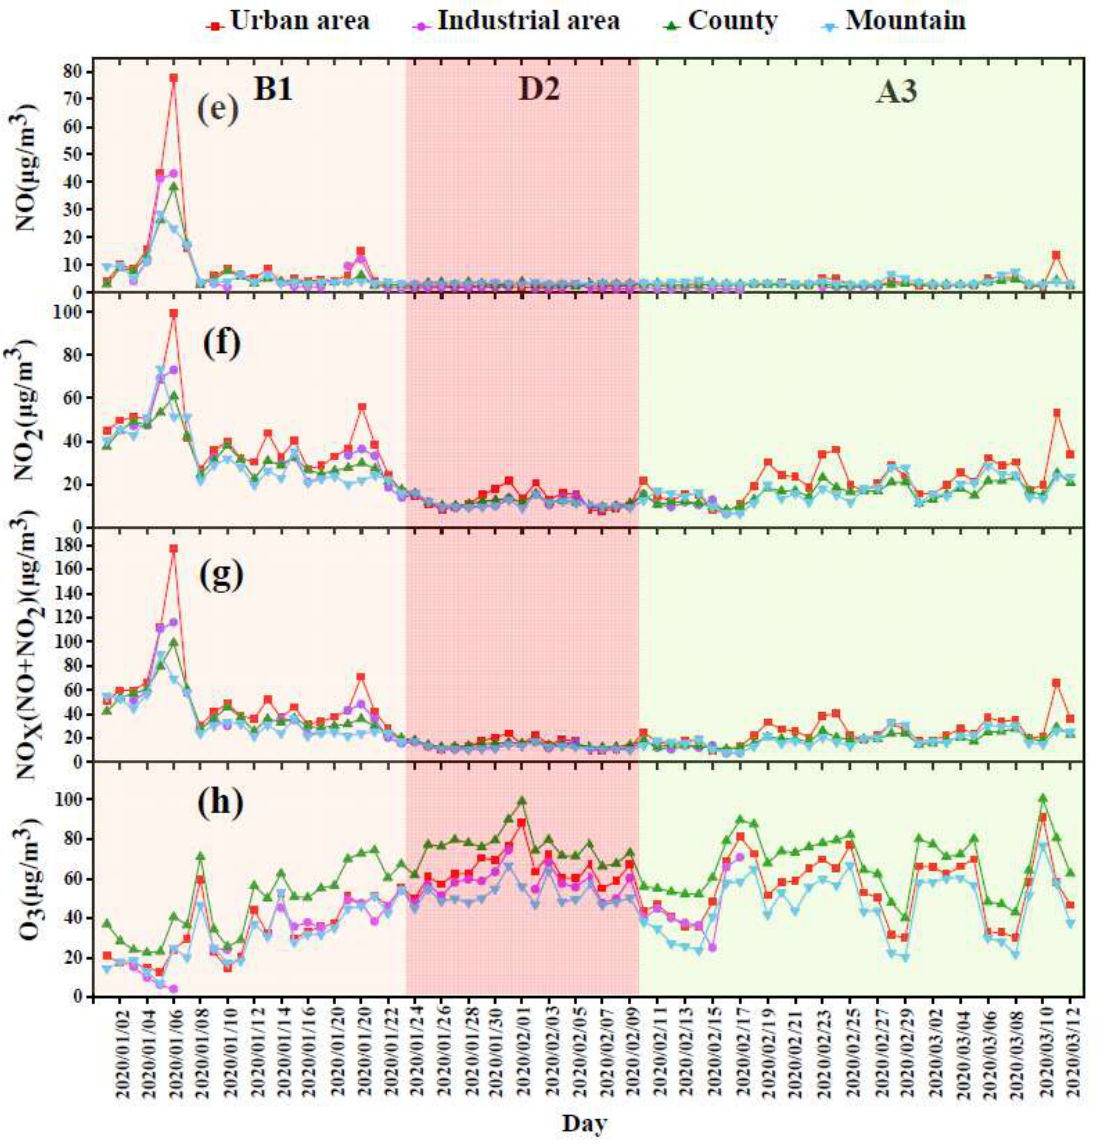
Figure 7. Daily mean concentrations of air pollutants of four regions in Nanchang from 1 January to 12 March 2020: ( e ) NO; ( f ) NO 2 ; ( g ) NOx; ( h ) O 3